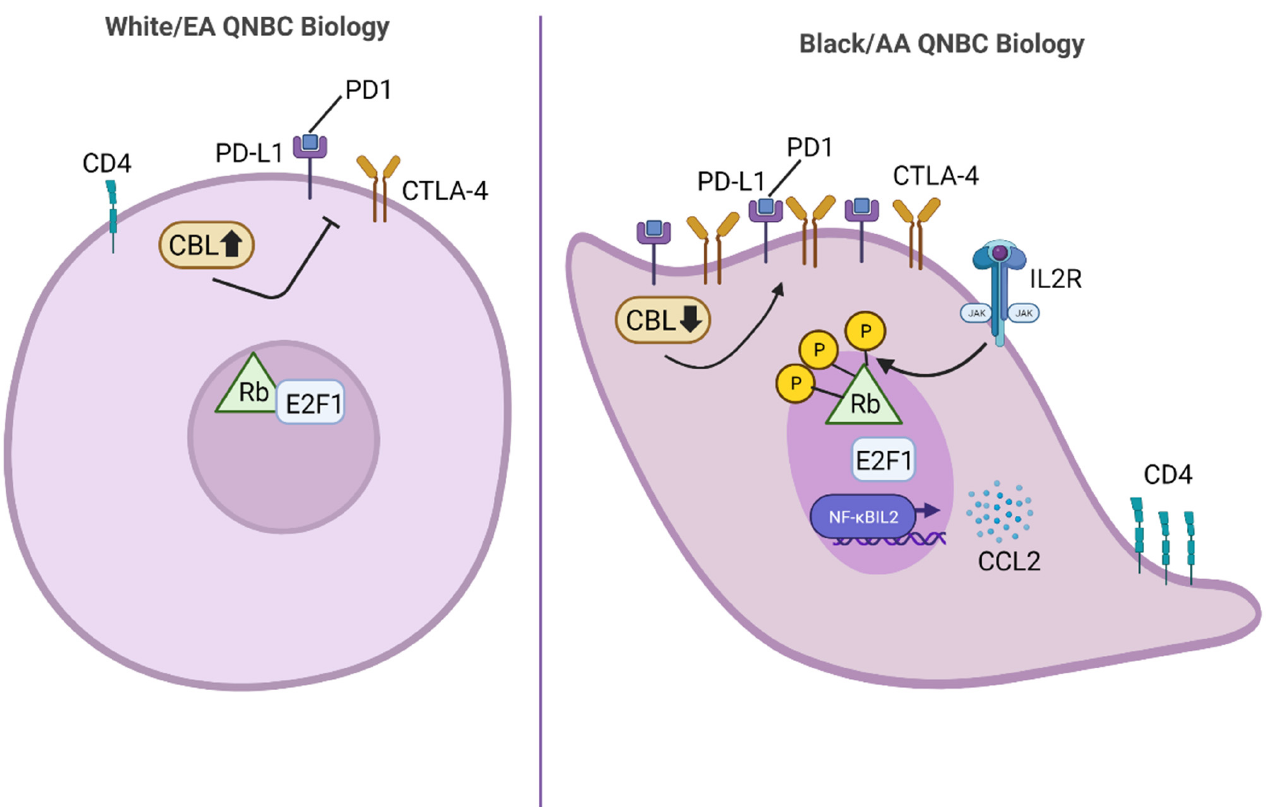
Figure 1. Distinctions in QNBC molecular cell biology among Black/AA and White/EA patients. Black/AA QNBCs have been shown to exhibit significantly upregulated levels of the T cell marker antigen, CD4, and immune checkpoint genes, PDL-1, PD1, CTLA-4 compared to White/EA QNBCs. In addition, Black/AA QNBCs have been reported to display significantly lower levels of CBL and significantly higher levels of E2F1, NFKBIL2, and CCL2 gene expression. CBL negatively regulates immune checkpoints; thus, downregulation of CBL in Black/AA QNBC cells can result in increased immune checkpoint activity. Observed upregulation of E2F1 in Black/AA QNBCs may be a result of increased IL2R signaling which can lead to hyperphosphorylation of Rb and thus, release of the E2F1 transcription factor. Upregulation of NFKBIL2 in Black/AA QNBCs can lead to increased transcription of cytokines and chemokines, such as CCL2. Abbreviations: PD-L1, programmed death-ligand; PD-1, programmed cell death protein 1; CTLA-4, cytotoxic T-lymphocyte-associated antigen 4; CBL, casitas B-lineage lymphoma; E2F1, E2 promoter binding factor 1; NFKBIL2, nuclear factor kappa B subunit 2; CCL2, chemokine (C-C motif) ligand 2; CD4, cluster of differentiation 4; IL2R, interleukin-2 receptor; JAK, Janus kinase; Rb, retinoblastoma.